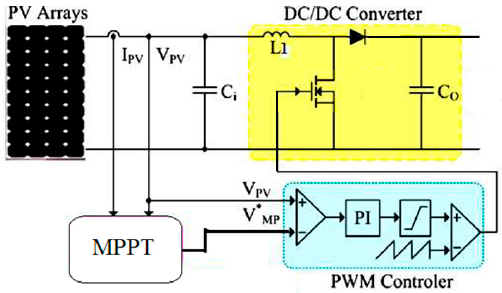
Figure 7. Control design for PV system.